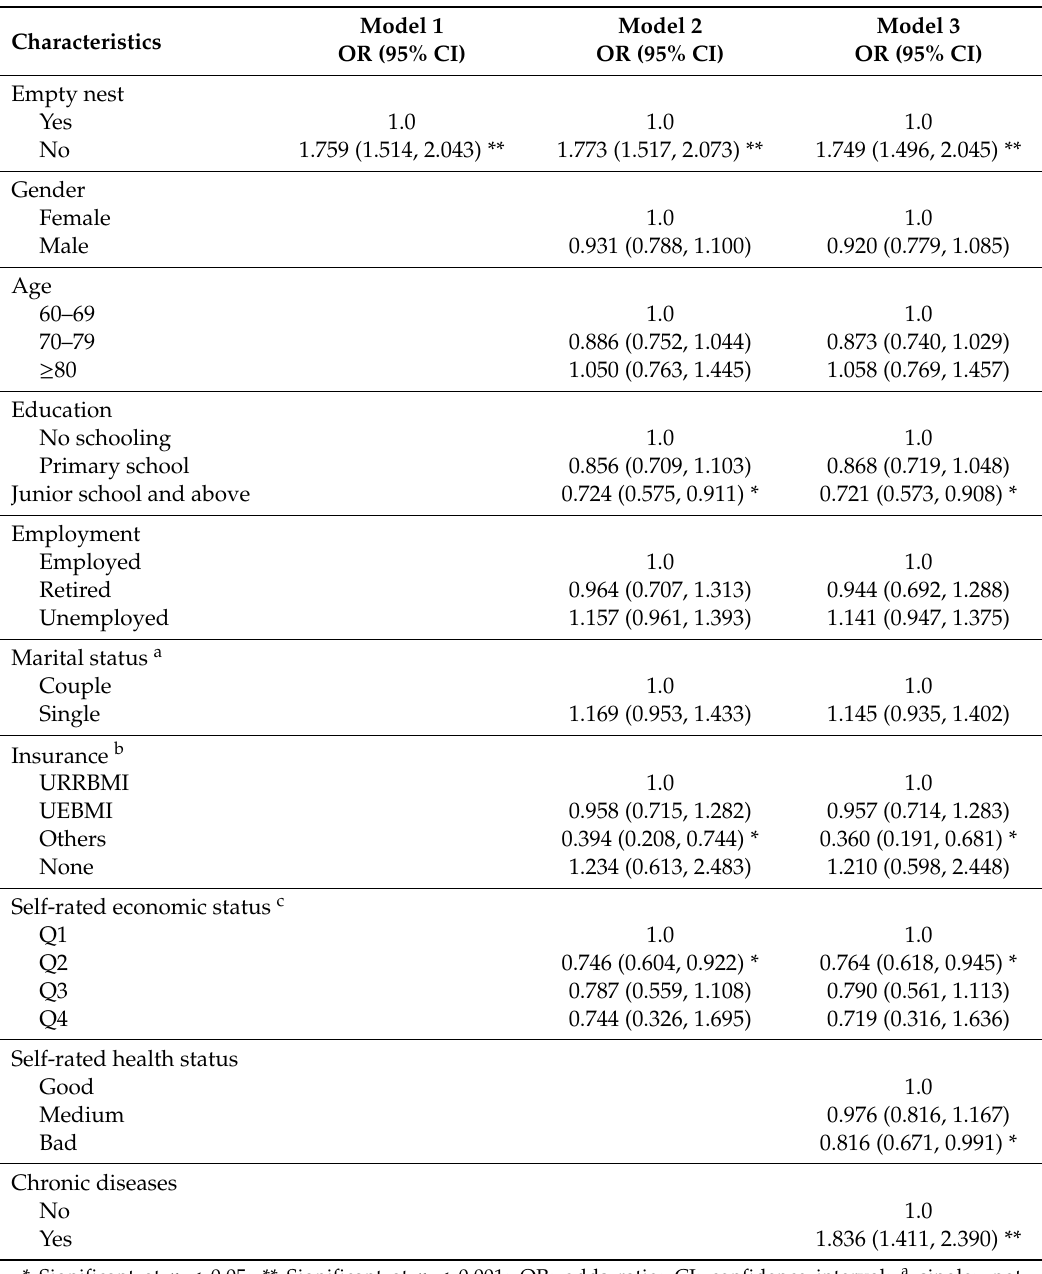
Table 2. Association of self-treatment and living arrangement in Shandong,